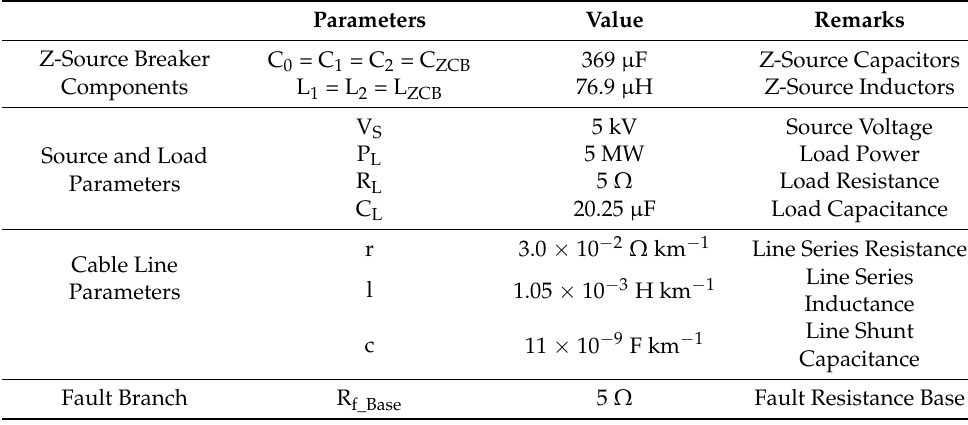
Table 1. Specifications of ZCB and line